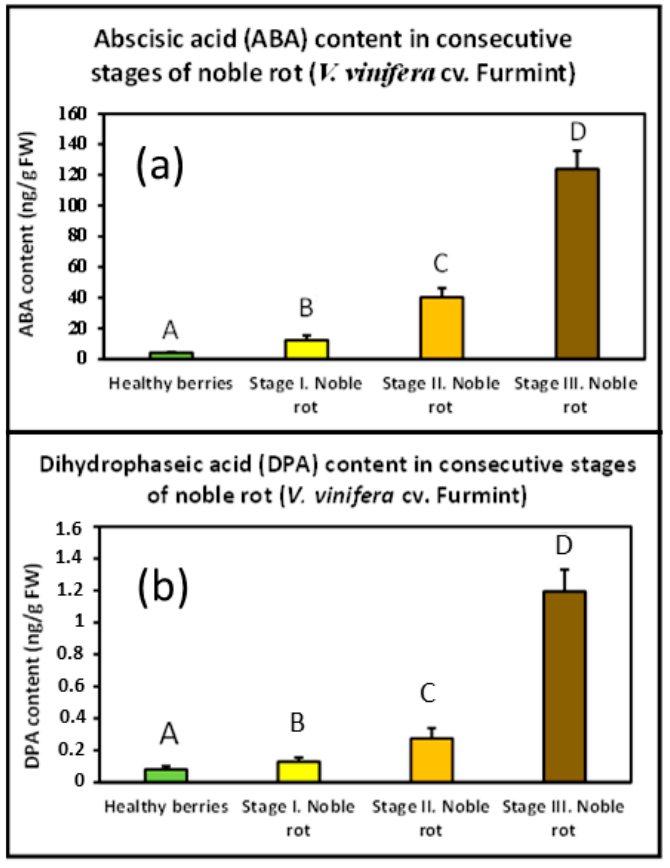
Figure 5. Noble rot-induced remodeling of abscisic acid (ABA) and dihydrophaseic acid (DPA) levels in Furmint samples. Values are means ± SEM, n = 6 for all groups. Data were log-transformed before analysis by ANOVA. Different letters indicate statistically significant differences at p ≤ 0.01. ( a ) ABA content in berries representing consecutive stages of noble rot; ( b ) DPA content in berries representing consecutive stages of noble rot.